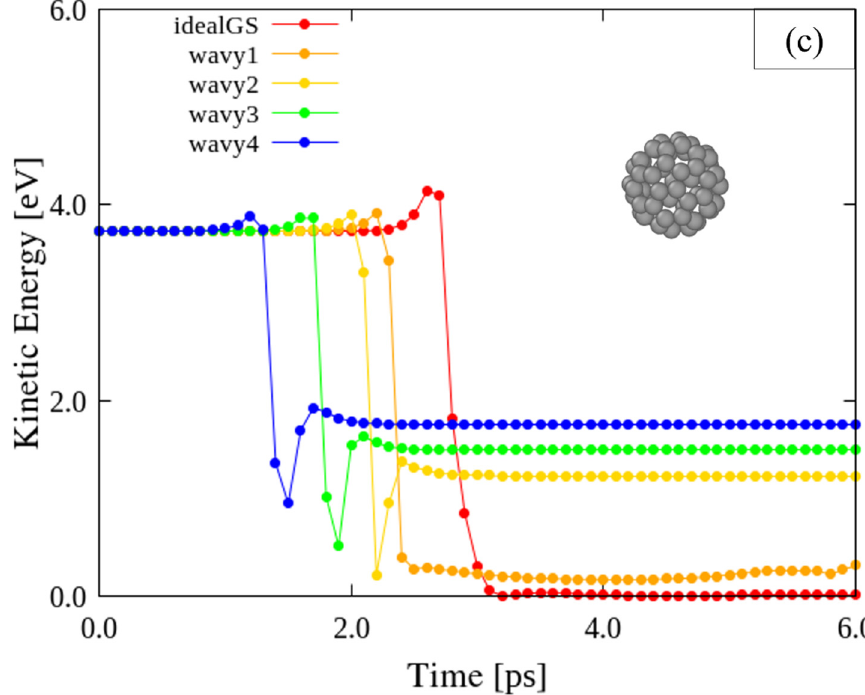
Figure 4. Relationship between impact energy and time during collisions between GSs and C 60 with an initial velocity v 0 of 10 Å/ps. ( a ) Comparison of KEs of the different types of GSs impacted by C 60 . ( b ) Comparison of ∆ E for the different types of GSs impacted by C 60 . ( c ) Comparison of KEs of C 60 impacting the different types of GSs.